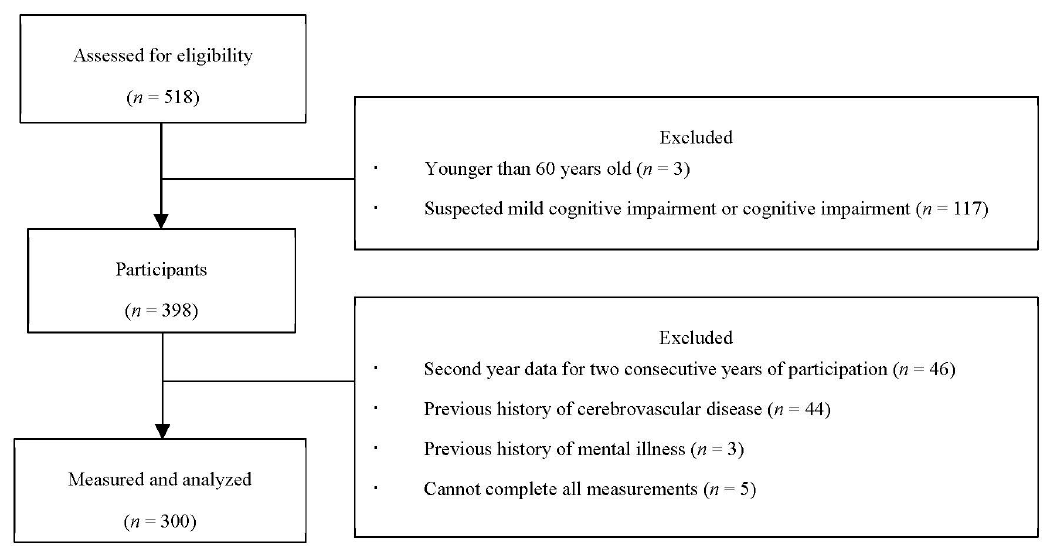
Figure 1. Flowchart of the selection process of the study participants.